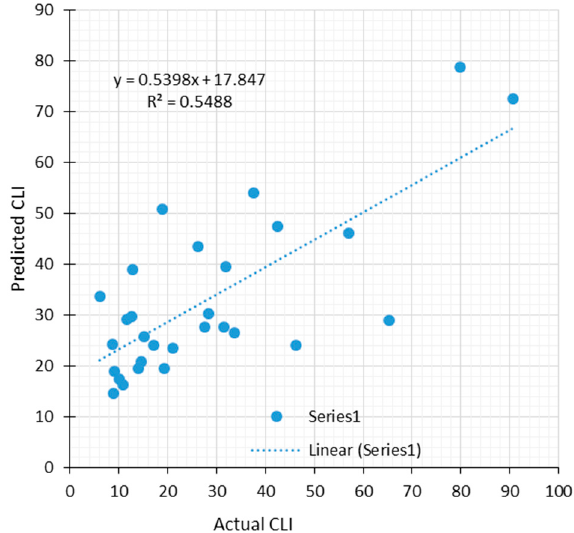
Figure 13. Relations between the measured CLI and predicted CLI for testing (model 1 ‐ NLMRM).